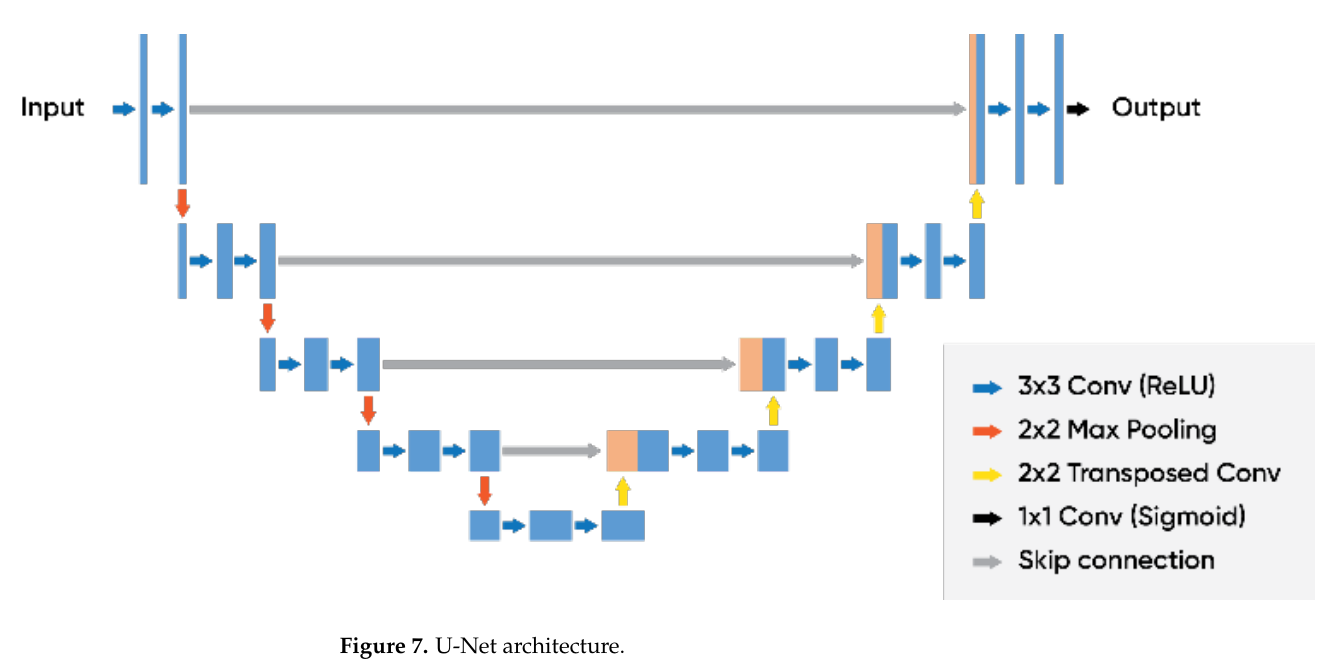
Figure 7. U-Net architecture.